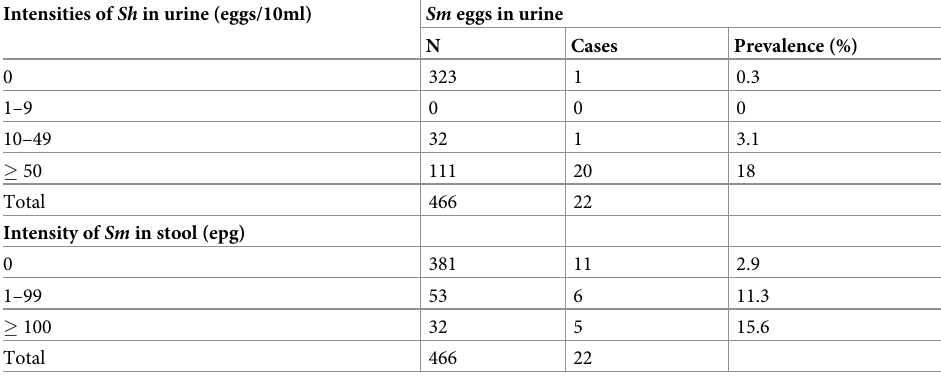
Table 3. Relation between ectopic Schistosoma mansoni eggs in urine and intensities of S. haematobium egg in urine and S.mansoni egg in stool. Intensities of Sh in urine